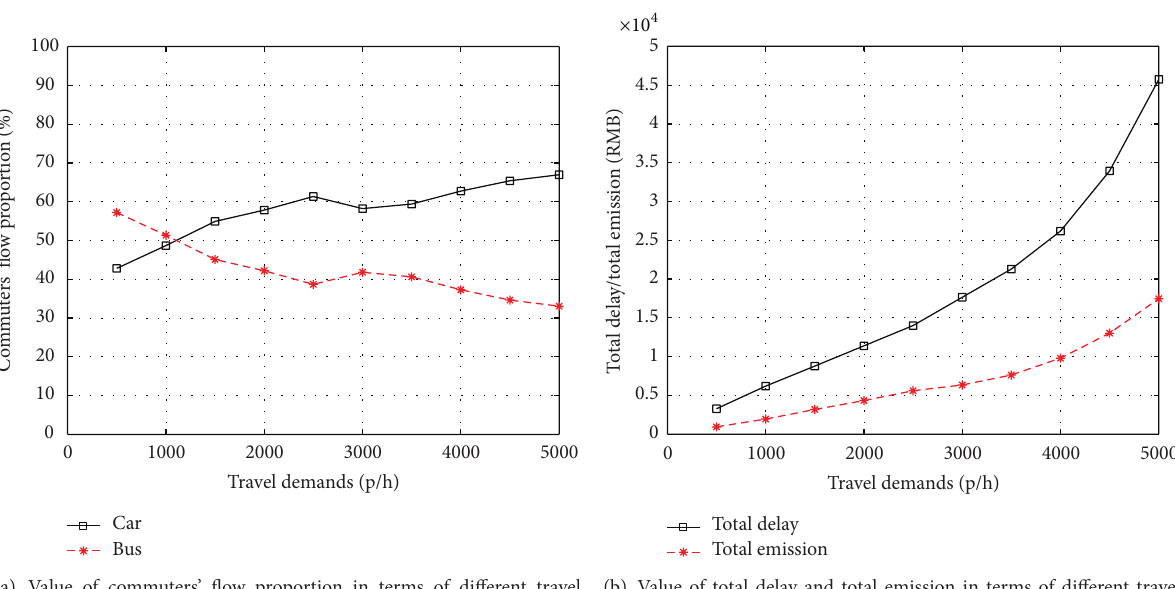
Figure 2: Sensitivity analysis of travel demand underpricing.